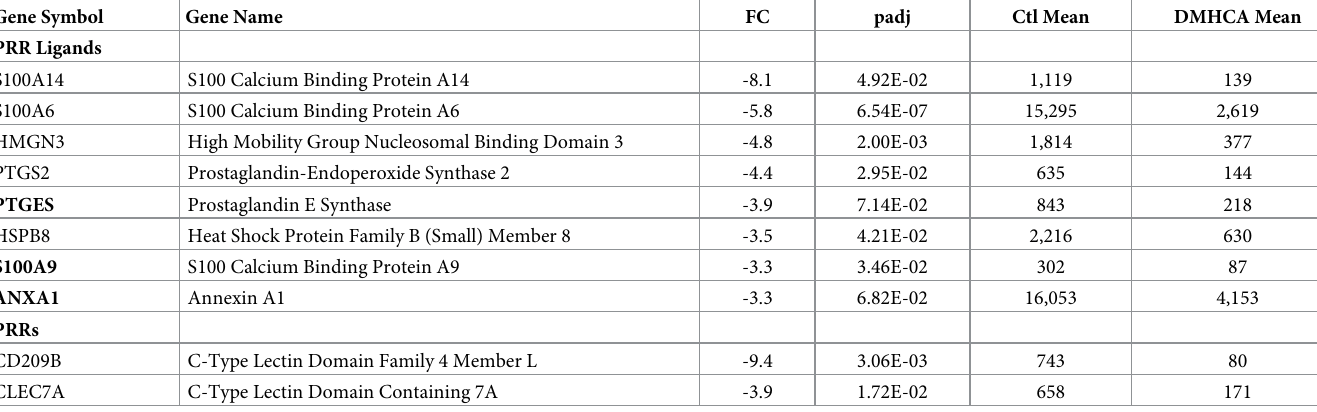
Shown are genes from S3 Table in S1 File with a raw score > 300, � 3-fold change in expression and a padj < 0.05. Genes in bold contain an LXR response element. PRRs, pattern recognition